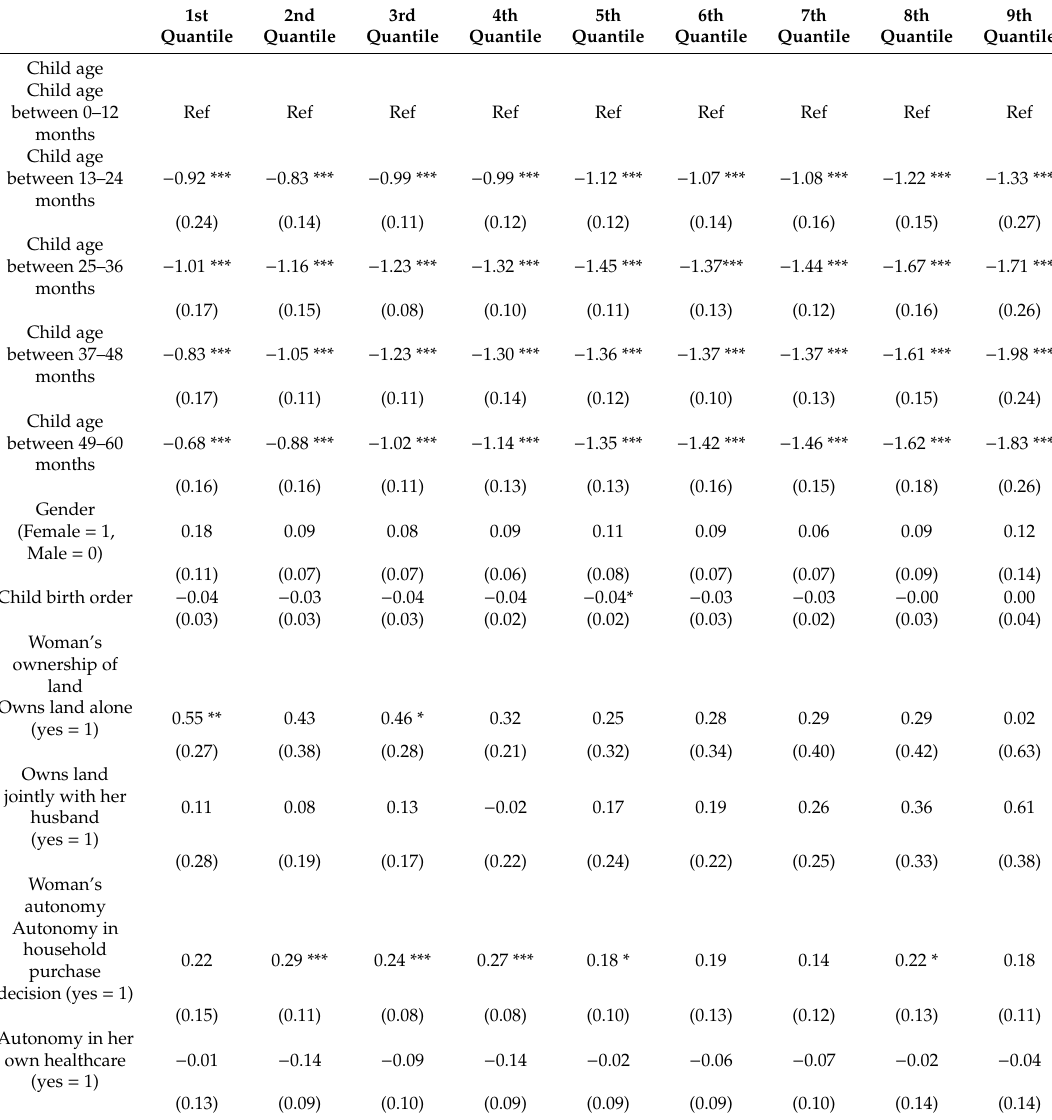
Table 4. Quantile regression model